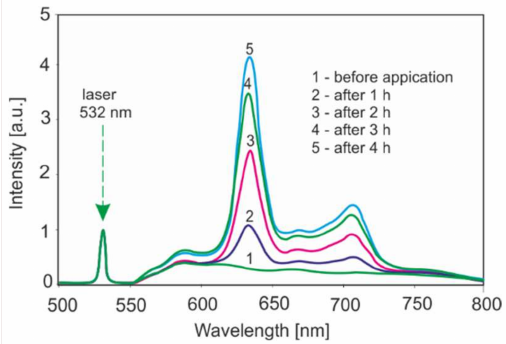
Figure 10. Kinetics of PPIX accumulation in alteration of skin actinic